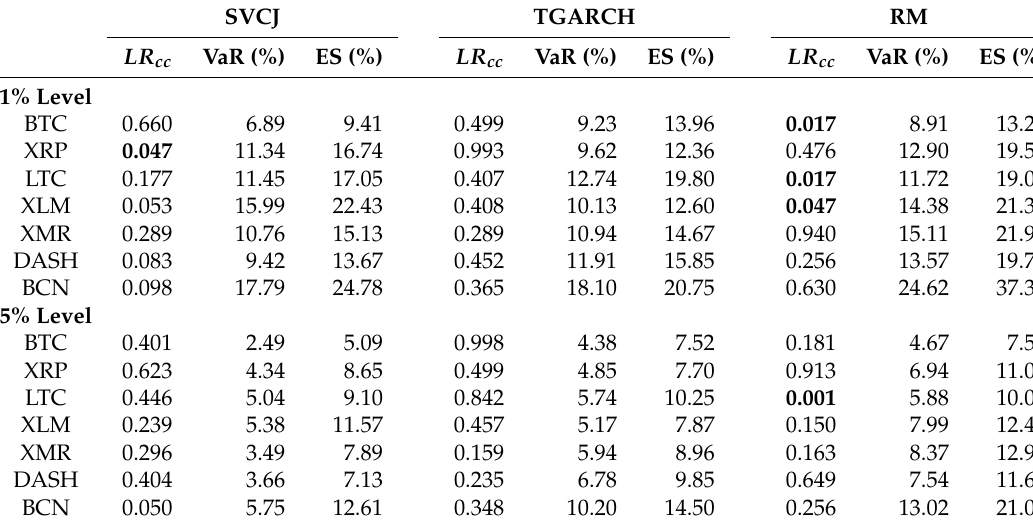
Table 4. Value-at-Risk backtesting results.